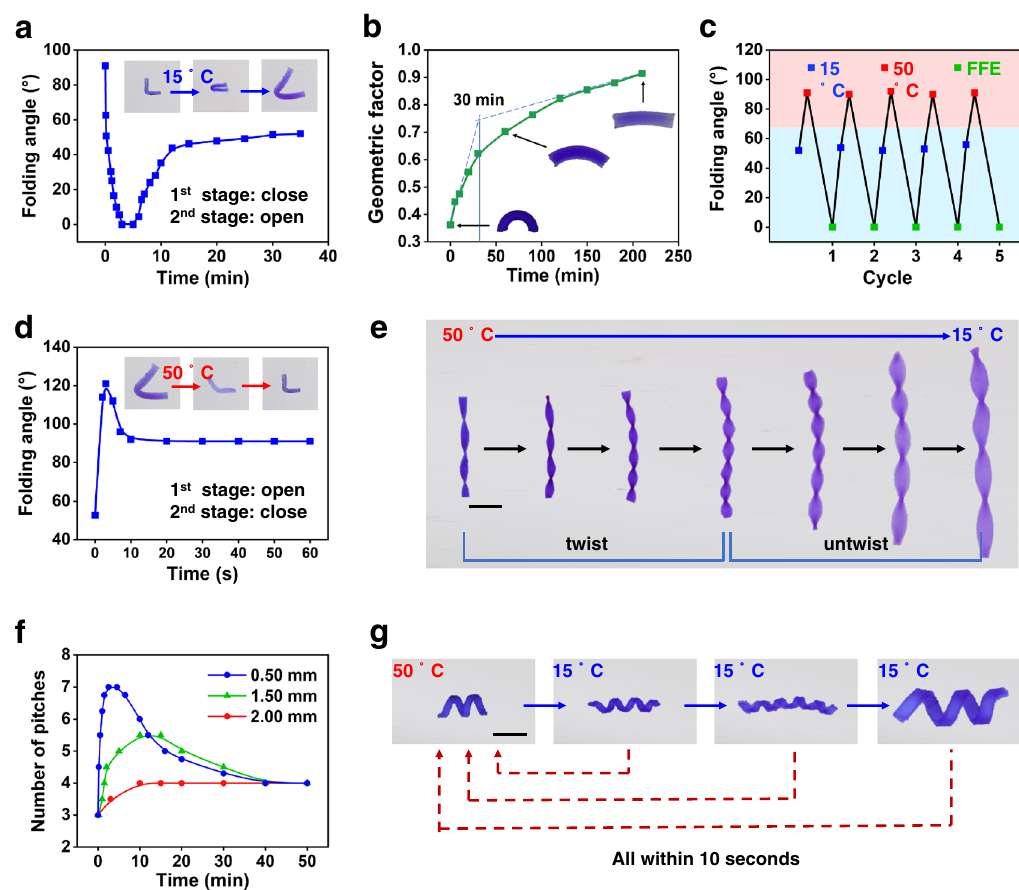
Fig. 3 Kinetics and reversibility of the FFE shape-shifting process. a FFE based shape-shifting kinetics upon cooling. b Conventional shape-shifting kinetics for a bilayer gel. c Reversibility of FFE shape-shifting. d FFE based shape-shifting kinetics upon heating. e Demonstration of the FFE based twist- untwist cycle. f Impact of the sample thickness on the twist-untwist shape-shifting. g Rapid reversion of the FFE shapes upon heating. Scale bar: 1 Fig. 3b. The results suggest that the FFE phenomenon not only diversi fi es the shape-shifting pathway but also markedly accel- erates the process. This unique FFE shape-shifting behavior is highly reproducible, as evidenced in the cyclic tests in Fig. 3c. We note that the FFE behavior is not limited to the cooling process.